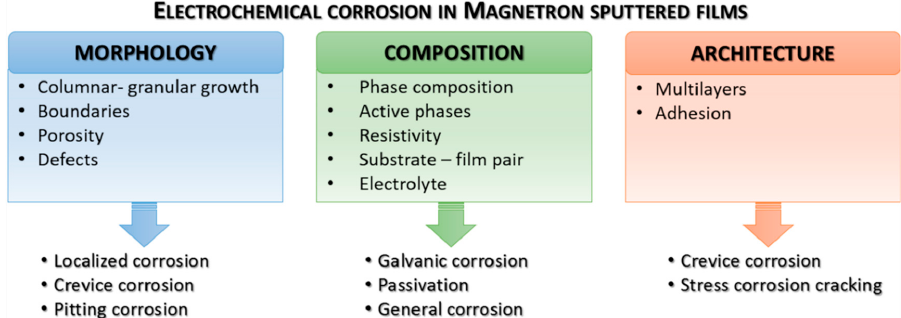
Figure 13. Characteristics of magnetron.sputtered films affecting the electrochemical corrosion.